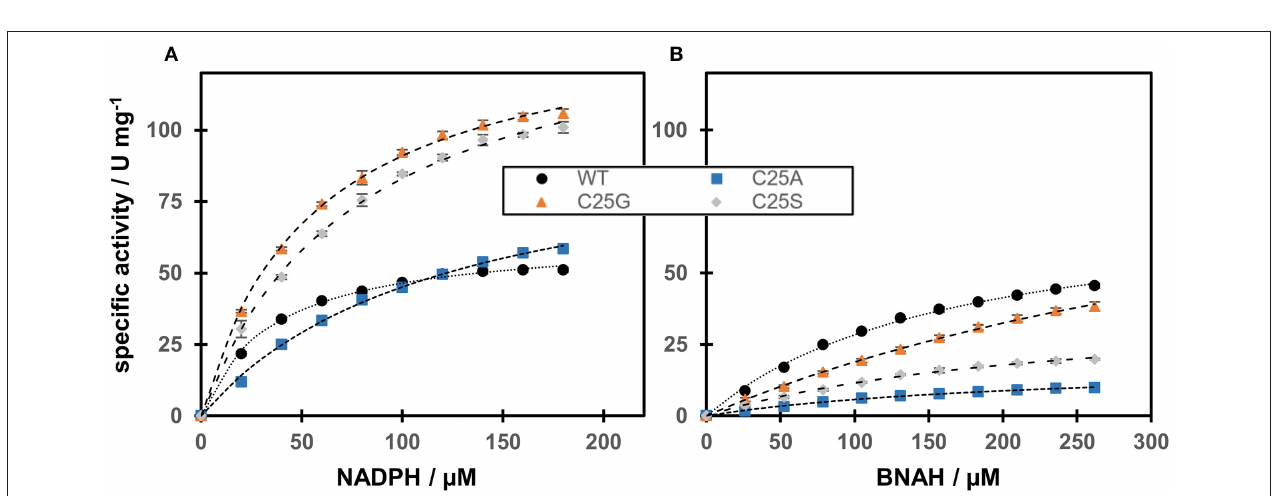
FIGURE 4 | Steady-state kinetics of OYERo2a (WT) and Cys variants regarding cofactor preference. The assay contained different amounts of nicotinamide cofactors NADPH (A) and BNAH (B) . The Michaelis-Menten model has been used to fit the data.